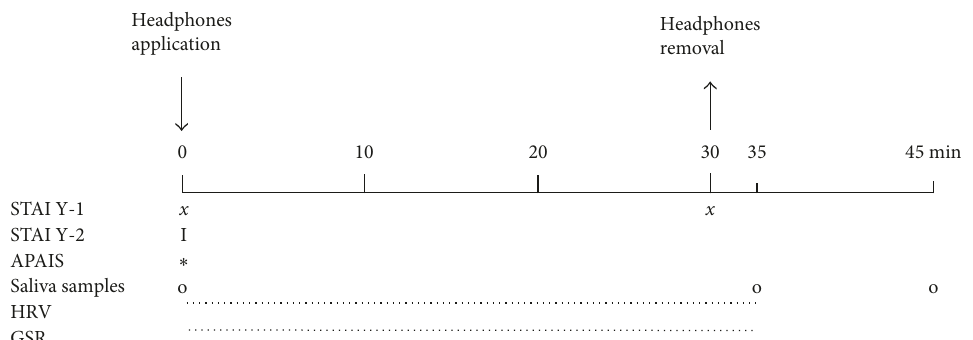
Figure 1: Timeline of the study procedure: State Trait Anxiety Inventory Questionnaire (STAI); Amsterdam Preoperative Anxiety and Information Scale (APAIS); heart rate variability (HRV); galvanic skin response (GSR).